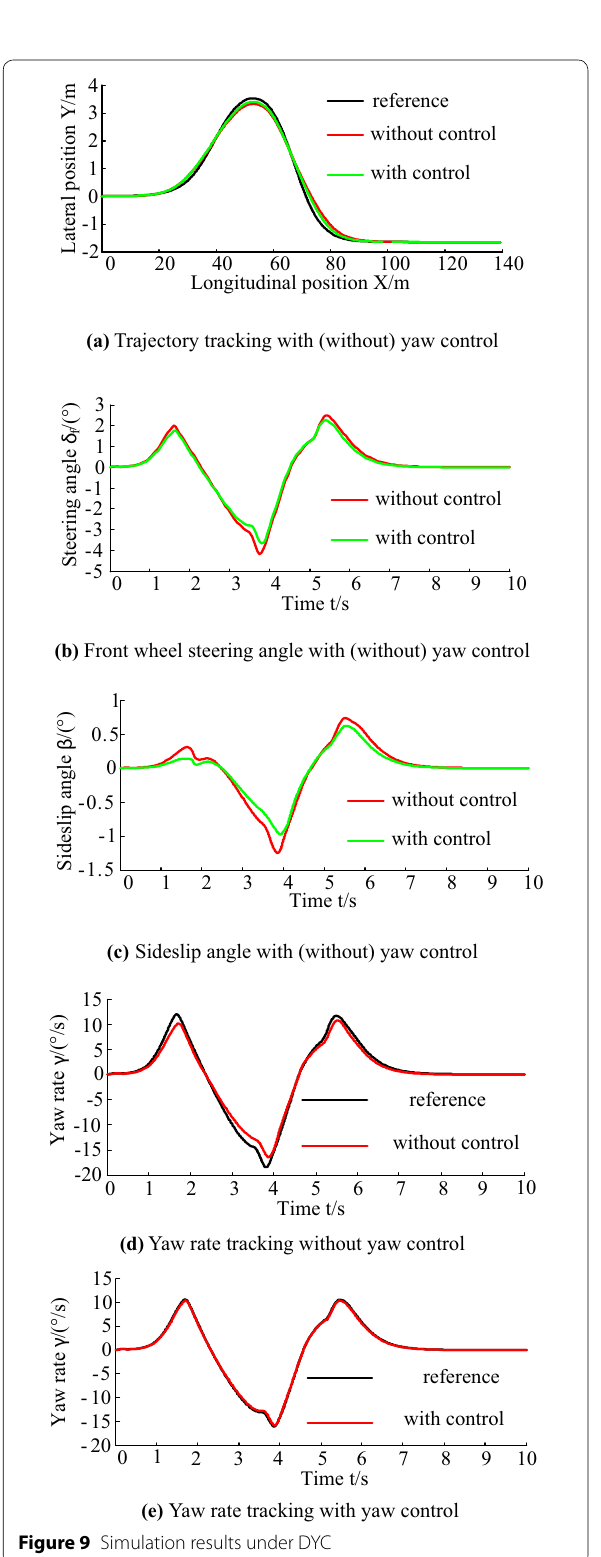
Figure 9 Simulation results under